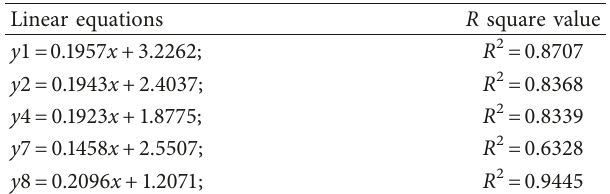
Table 4: Linear equations and R -square value for most repre- sentative mixtures (own source).